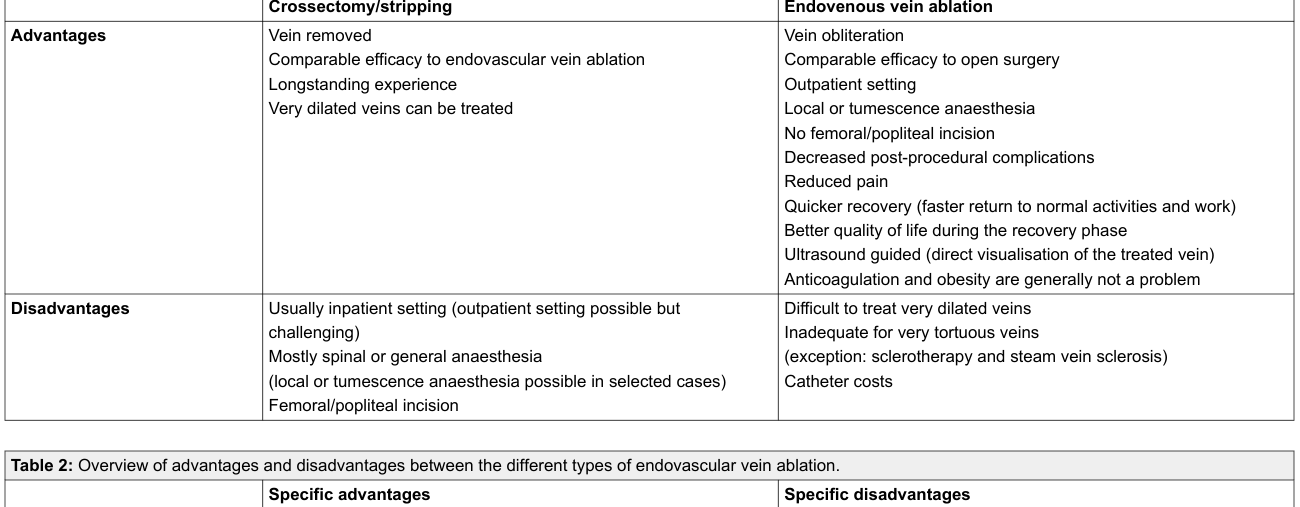
Table 2: Overview of advantages and disadvantages between the different types of endovascular vein